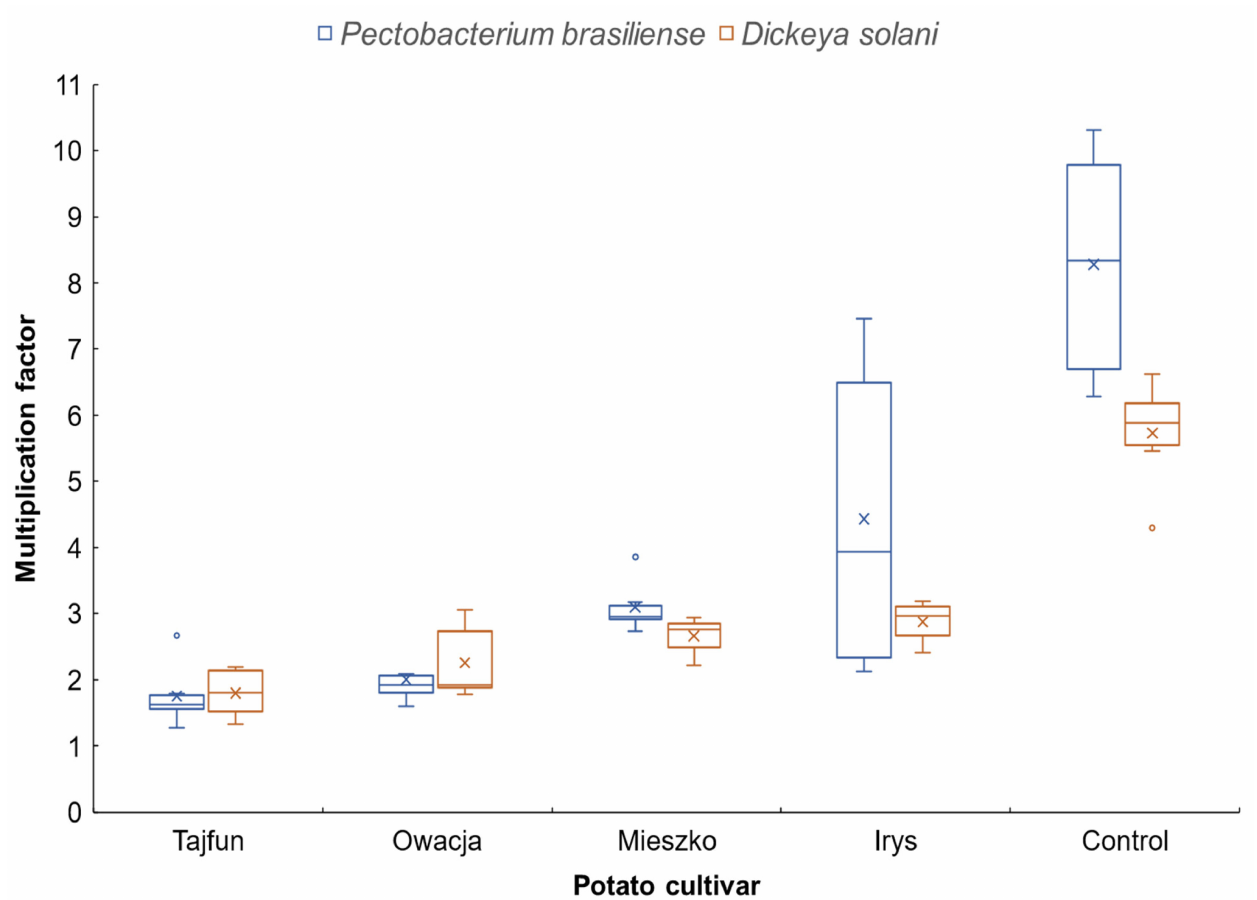
Figure 1. Average multiplication factor (MF) of P. brasiliense and D. solani 24 h after incubation in Luria Berthani medium (control) and Luria Berthani medium with glycoalkaloids isolated from leaves of four potato cultivars; x represents the mean of MF, error bars indicate the minimum and maximum values; the band inside the box represents median from nine replications in each of two independent experiments; the circles represent